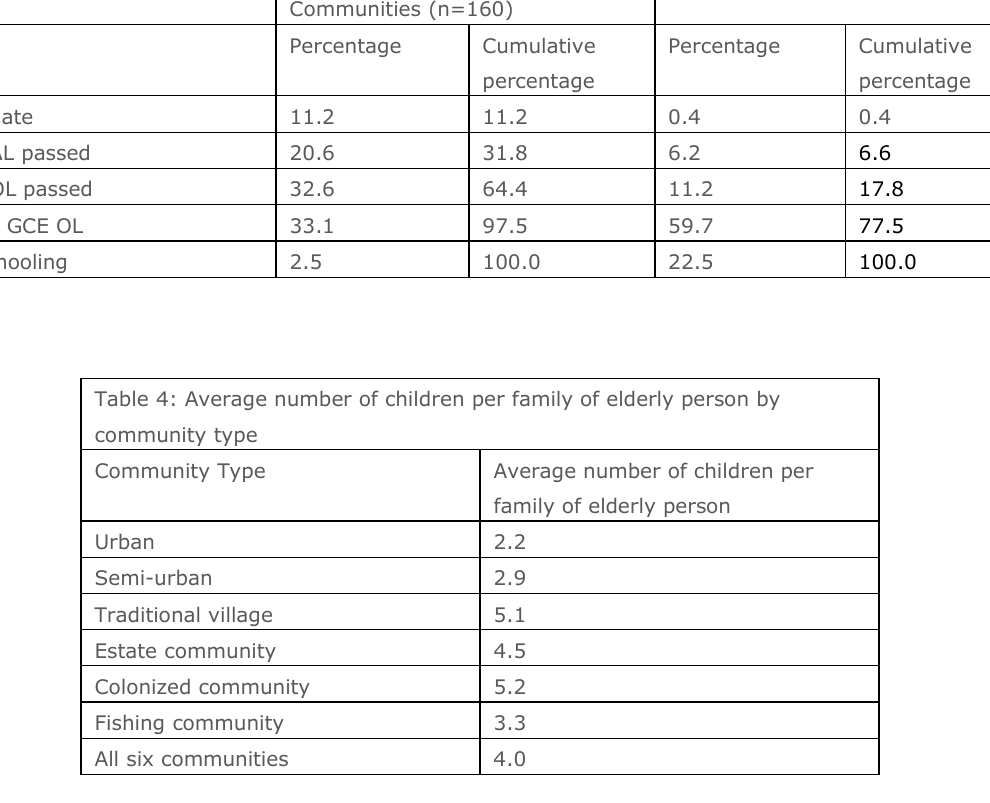
Table 3: Level of education of elderly persons in urban / semi-urban communities vs the other communities in the sample Urban and semi-urban All other communities (n=320) Communities (n=160) Percentage Cumulative